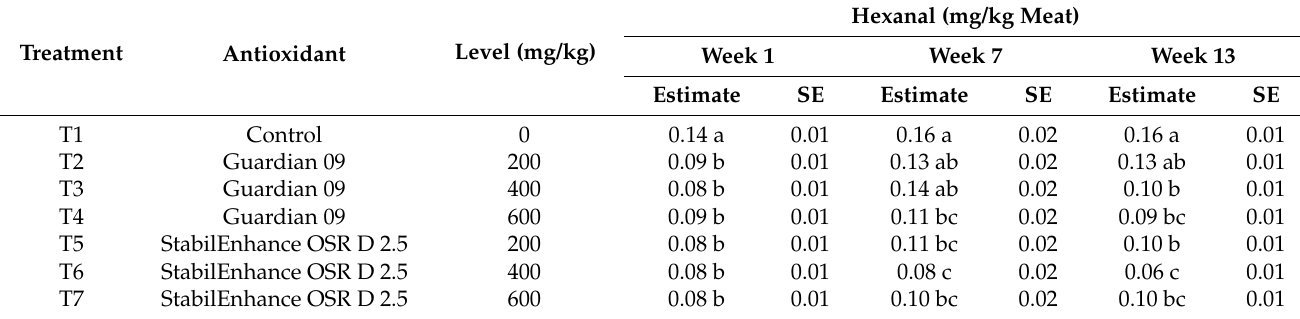
Table 1. Hexanal content (mg/kg meat) in cured deli turkey. Estimate indicates the mean hexanal content for triplicate determinations. Means with different letters within each week indicate significant difference ( p ≤ 0.05) between treatments.